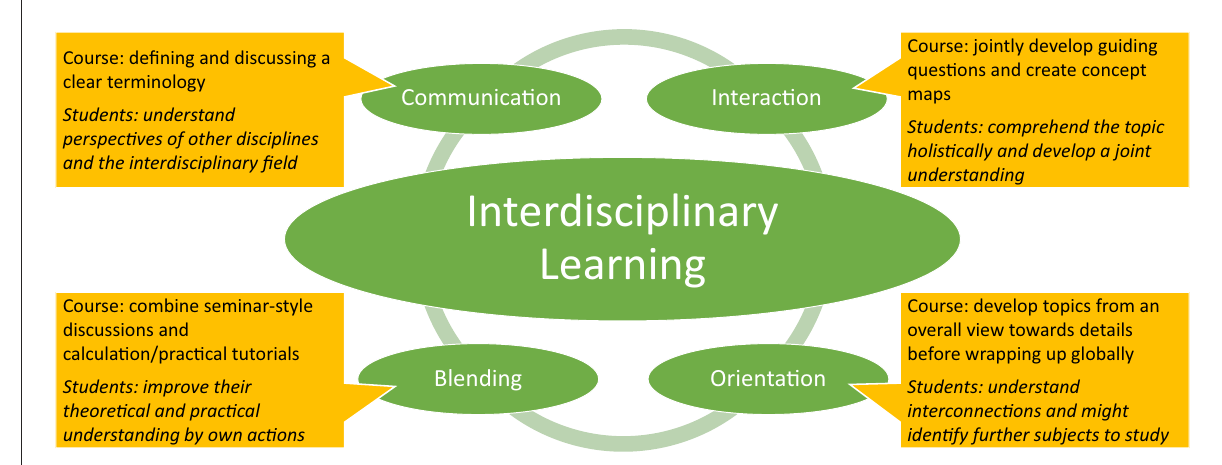
FIGURE1 We propose emphasis on developing joint communication, promoting interaction, blending teaching elements, and proving students with orientation to improve their interdisciplinary learning. The yellow boxes suggest concrete actions that could be taken for implementation, which are describe in more detail in the